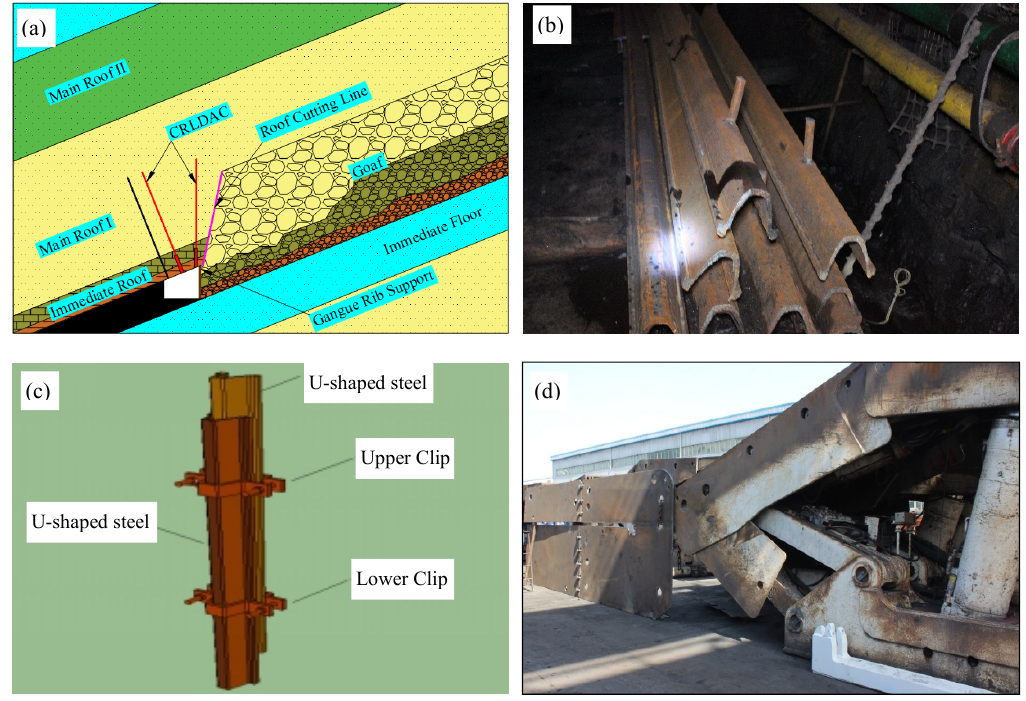
Figure 5. Gangue-rib support device: ( a ) location of Gangue-rib support; ( b ) U-shaped steel; ( c ) U-shaped shed; ( d ) antishock device.